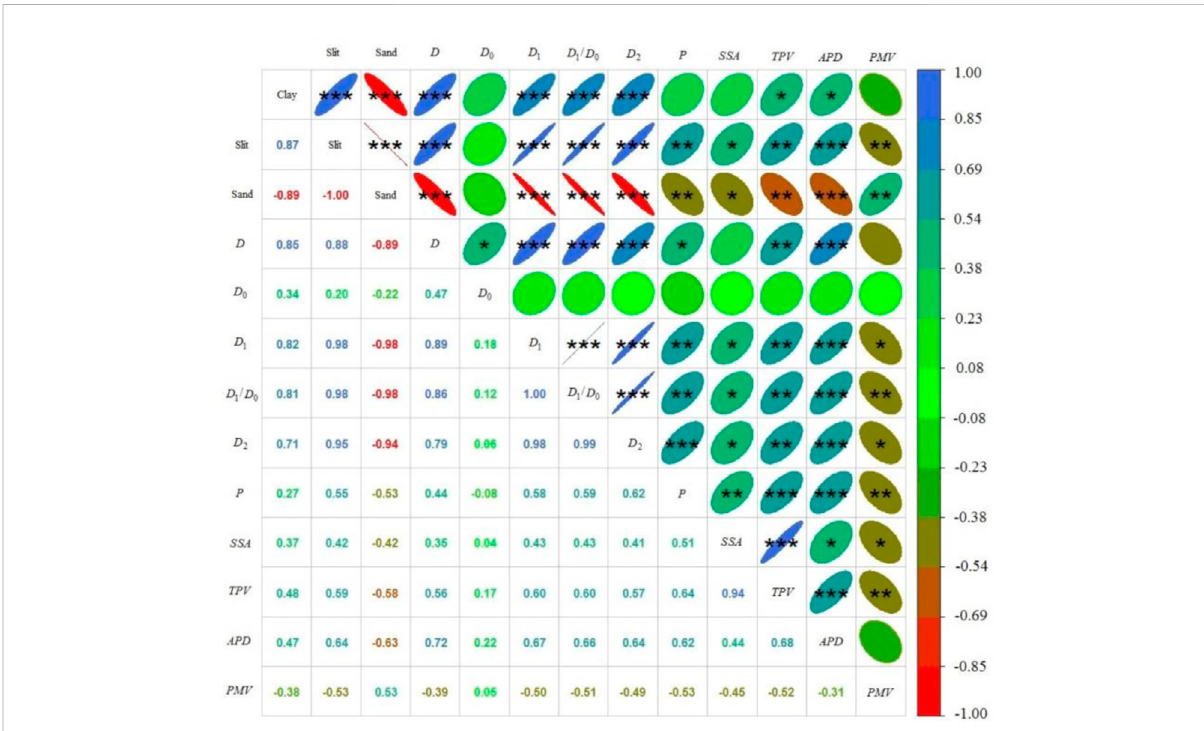
FIGURE 8 CorrelationsbetweenthesoilPSDandporecharacteristics.Blueindicatesapositivecorrelation,redindicatesanegativecorrelation, *indicates asigni fi cant correlation atthe 0.05 level ( p < 0.05), ** indicates asigni fi cant correlation at p < 0.01, *** indicates asigni fi cant correlation at p < 0.001. The eccentricity of the ellipse and the color indicate the intensity of the correlation.